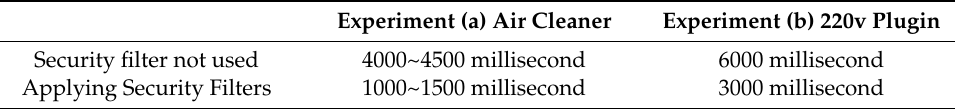
Table 4. Device response time when security filter is applied after abnormal packet